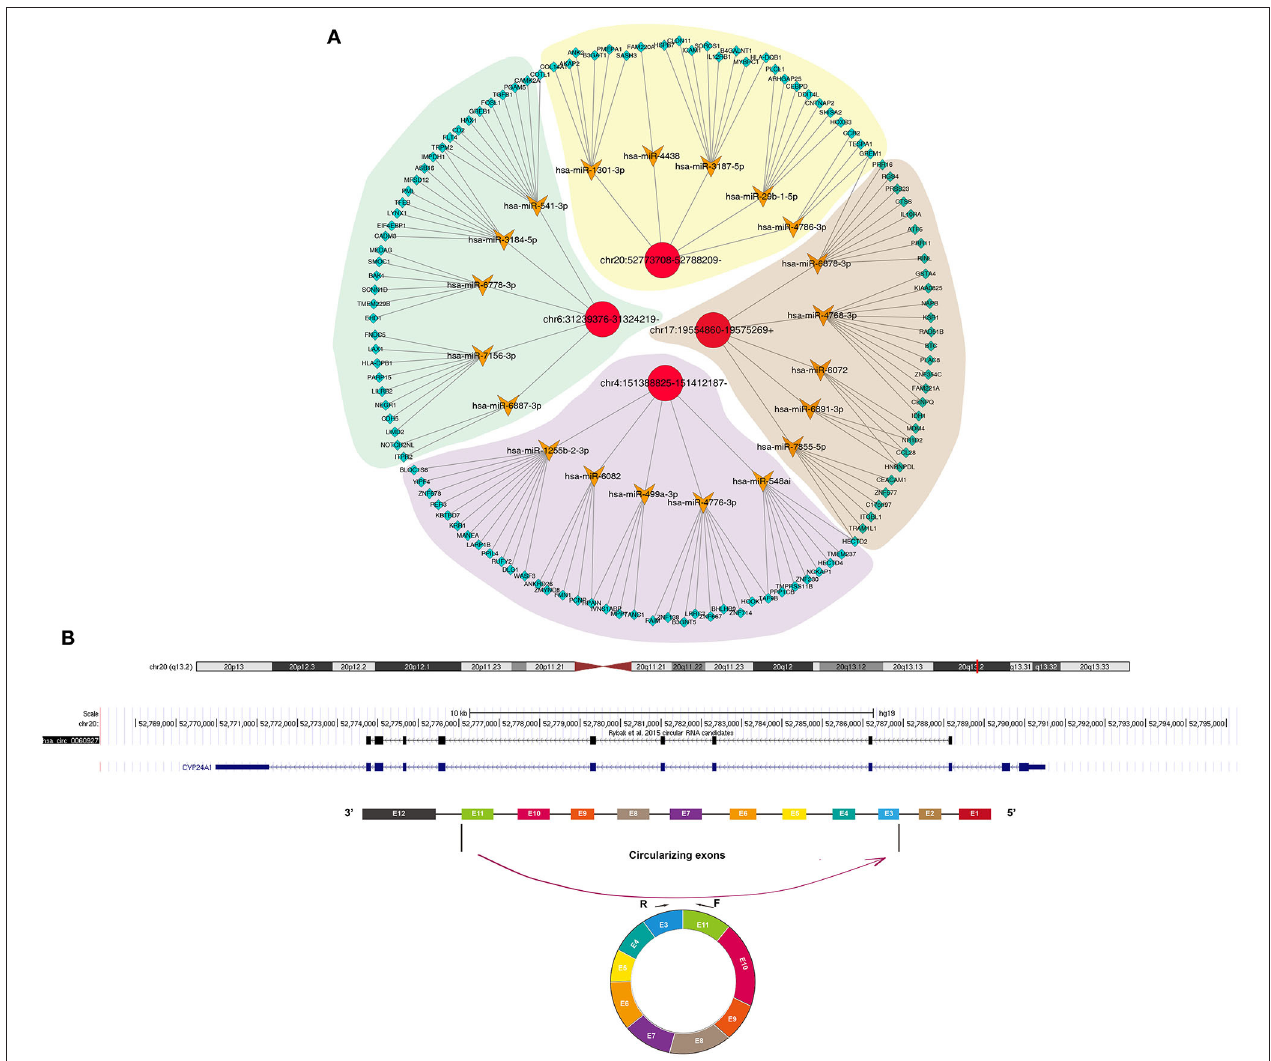
FIGURE 3 | Construction of a circRNA-miRNA-mRNA network for cSCC. (A) The potential binding miRNAs and mRNAs for differentially expressed circRNAs. (B) Schematic diagram of the structure of